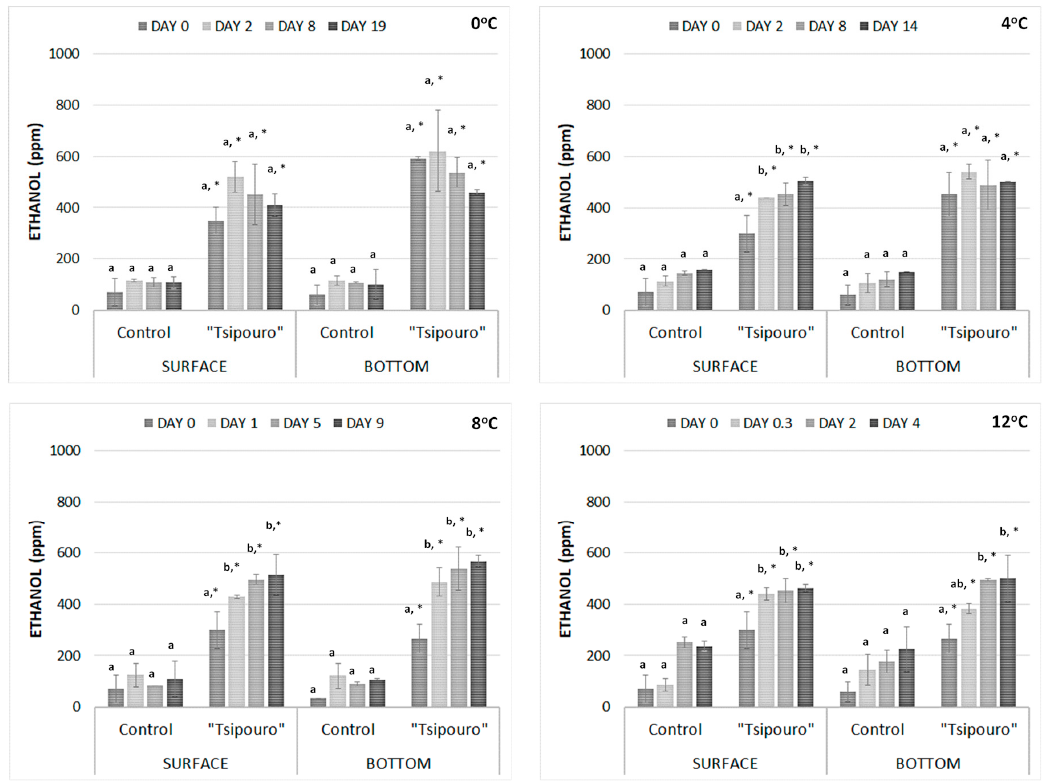
Figure 7. Ethanol in ground beef (ppm) packaged with absorbent pads supplemented with a total volume of 50 mL “ tsipouro ” (40 mL under the ground beef piece and 10 mL under the labelling, facing the headspace) under 80% O 2 : 20% CO 2 at 0, 4, 8, and 12 °C. Samplings were performed in depth of 1 cm either from the surface or from the bottom side of the 500 g ground beef piece. Untreated samples served as controls. Bars under the same conditions (treatment, sampling side, and storage temperature) having different lowercase letter are significantly different from each other ( p < 0.05); Star indicates statistical significance of “ tsipouro ” treatment in comparison to controls under the same conditions (sampling side, storage day, and temperature) (*: p < 0.05).